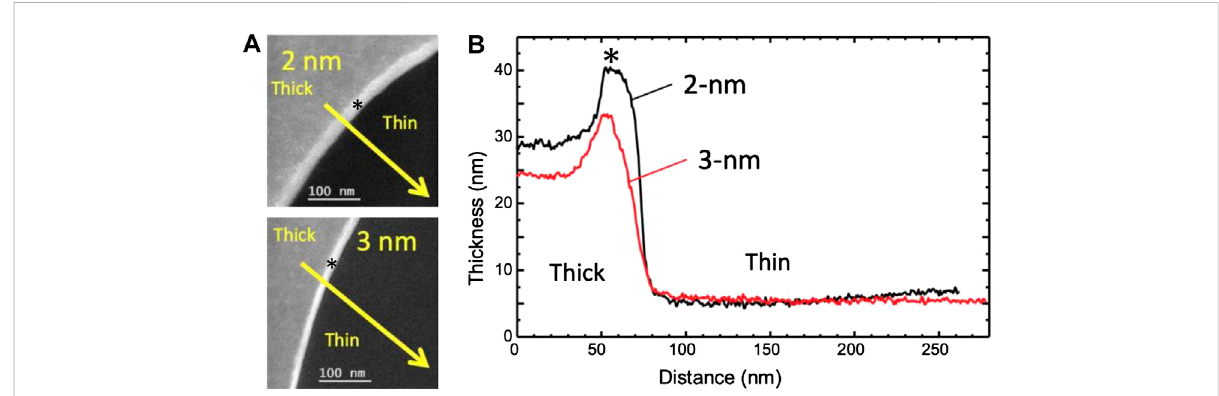
FIGURE 3 Thickness maps of Quantifoil 300 mesh carbon grid with 2 or 3 nm continuous carbon layer (A) Thickness maps were recorded as explained in the text, in a region such as that squared in Supplementary Figure S1A, on a 2 nm membrane (A1) and a 3 nm membrane (A2). (B) Thickness pro fi les were recorded along the yellow arrows in (A) , where the inelastic mean free path λ has been set to 130 nm: 2 nm nominal thickness in black, and 3 nm in red. The thickness maximum at both thick part edges is partly an artifact due to the presence of a Fresnel fringe (represented by the sign *).